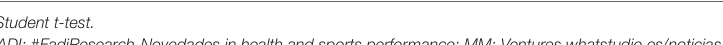
Minimum Maximum